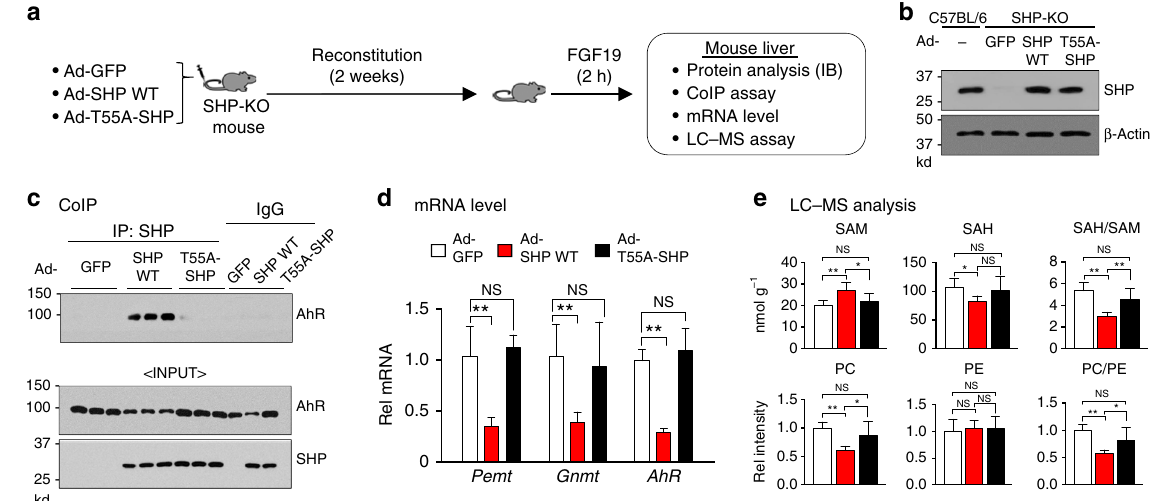
Fig. 6 FGF19-induced phosphorylation of SHP at T55 is required for functional interaction with AhR. a Experimental outline: SHP-KO mice ( n = 5 mice per group) were injected via the tail vein with control Ad-GFP, Ad-SHP-WT or p-defective Ad-T55A-SHP, and 2 weeks later, mice were treated with FGF19 for 2 h, and livers were collected. b Protein levels of SHP-WT or T55A-SHP in liver extracts were detected by IB. c The interaction between SHP-WT or T55A- SHP with AhR was determined by CoIP using whole cell liver extracts. AhR and SHP protein levels in input samples are shown. Full size immunoblots are in Supplementary Figure 12c. d mRNA levels of Pemt , Gnmt , and AhR were determined by qRT-PCR. e Selected 1C cycle metabolites levels were determined by LC – MS and the ratios of SAH/SAM and PC/PE were calculated. Means ± SD ( n = 5) are shown, and statistical signi fi cance was measured using the d , e one-way ANOVA with the FDR post-test. * P < 0.05, ** P < 0.01, NS, not statistically signi fi